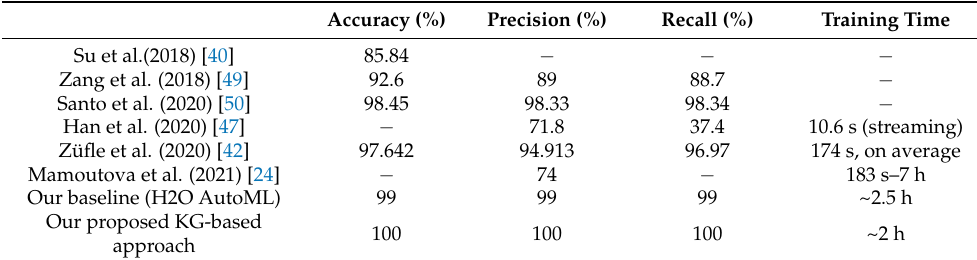
Table 7. Comparison with state of the art